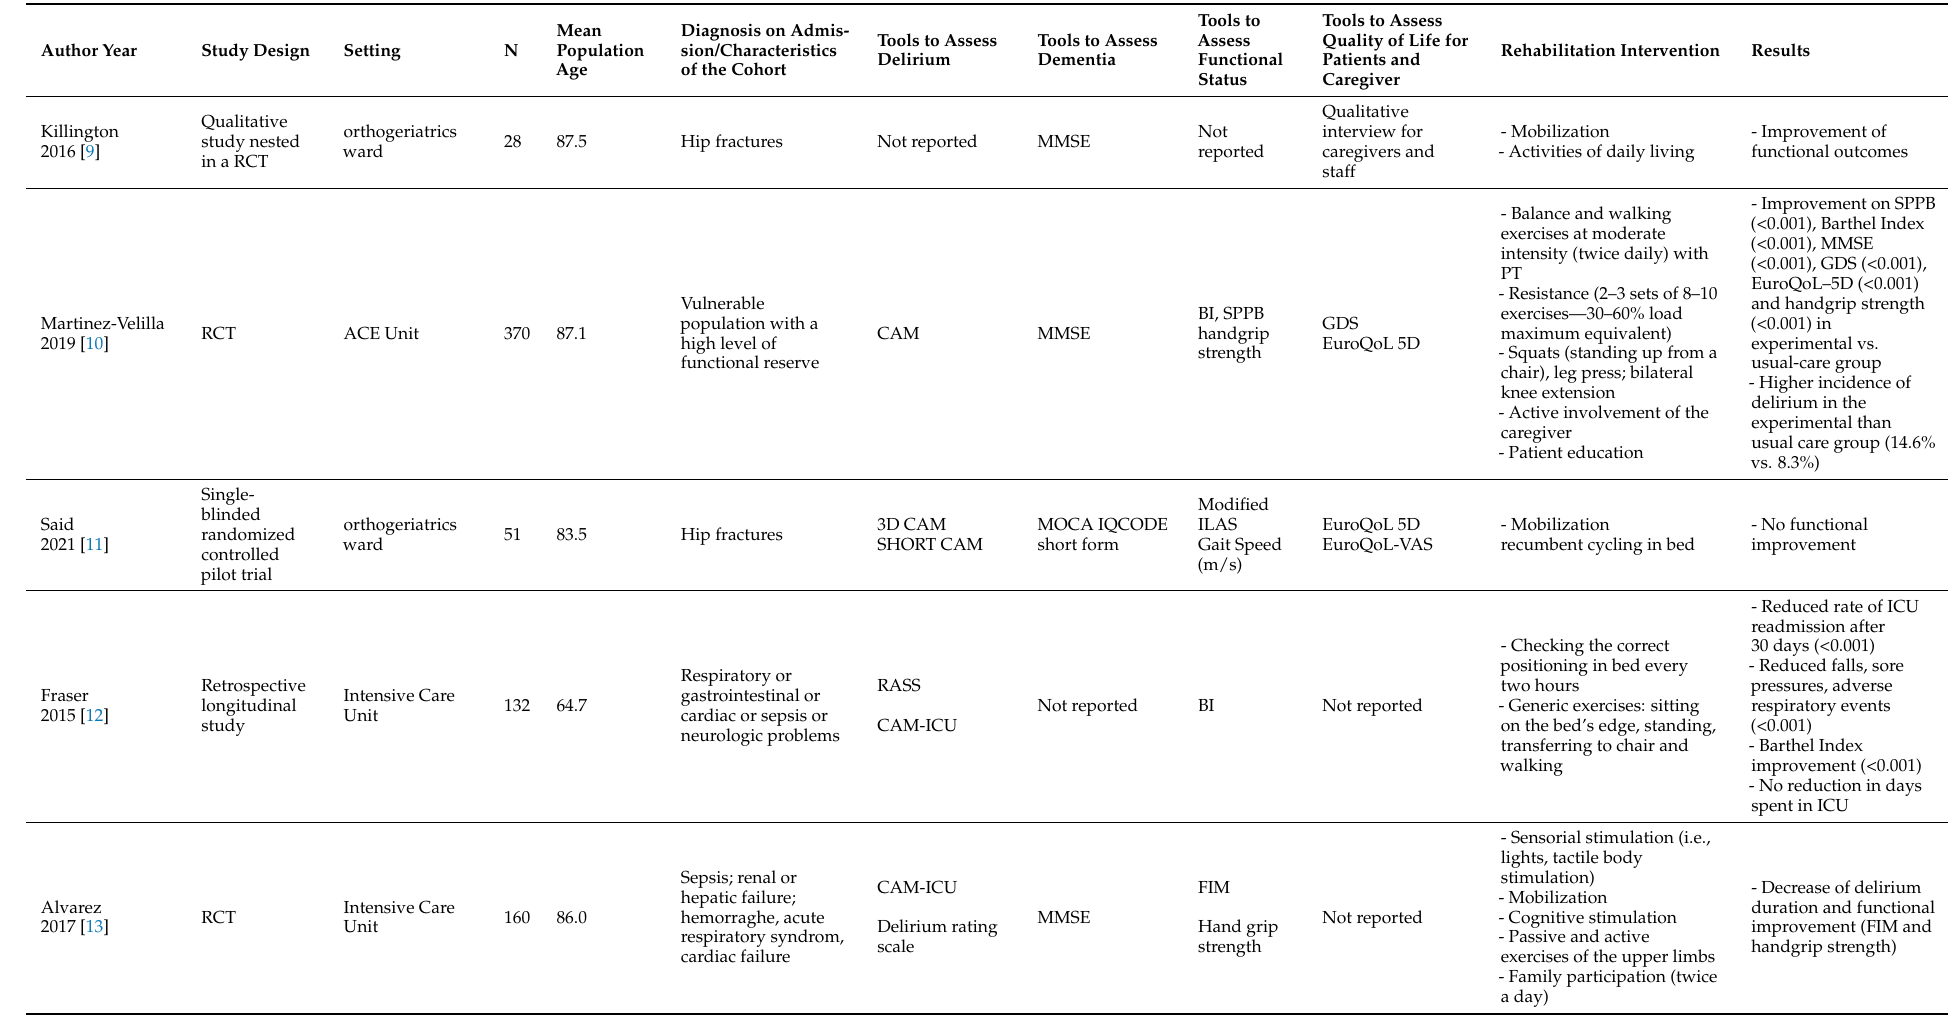
Table 1. Main characteristics and findings of the 9 articles selected for the